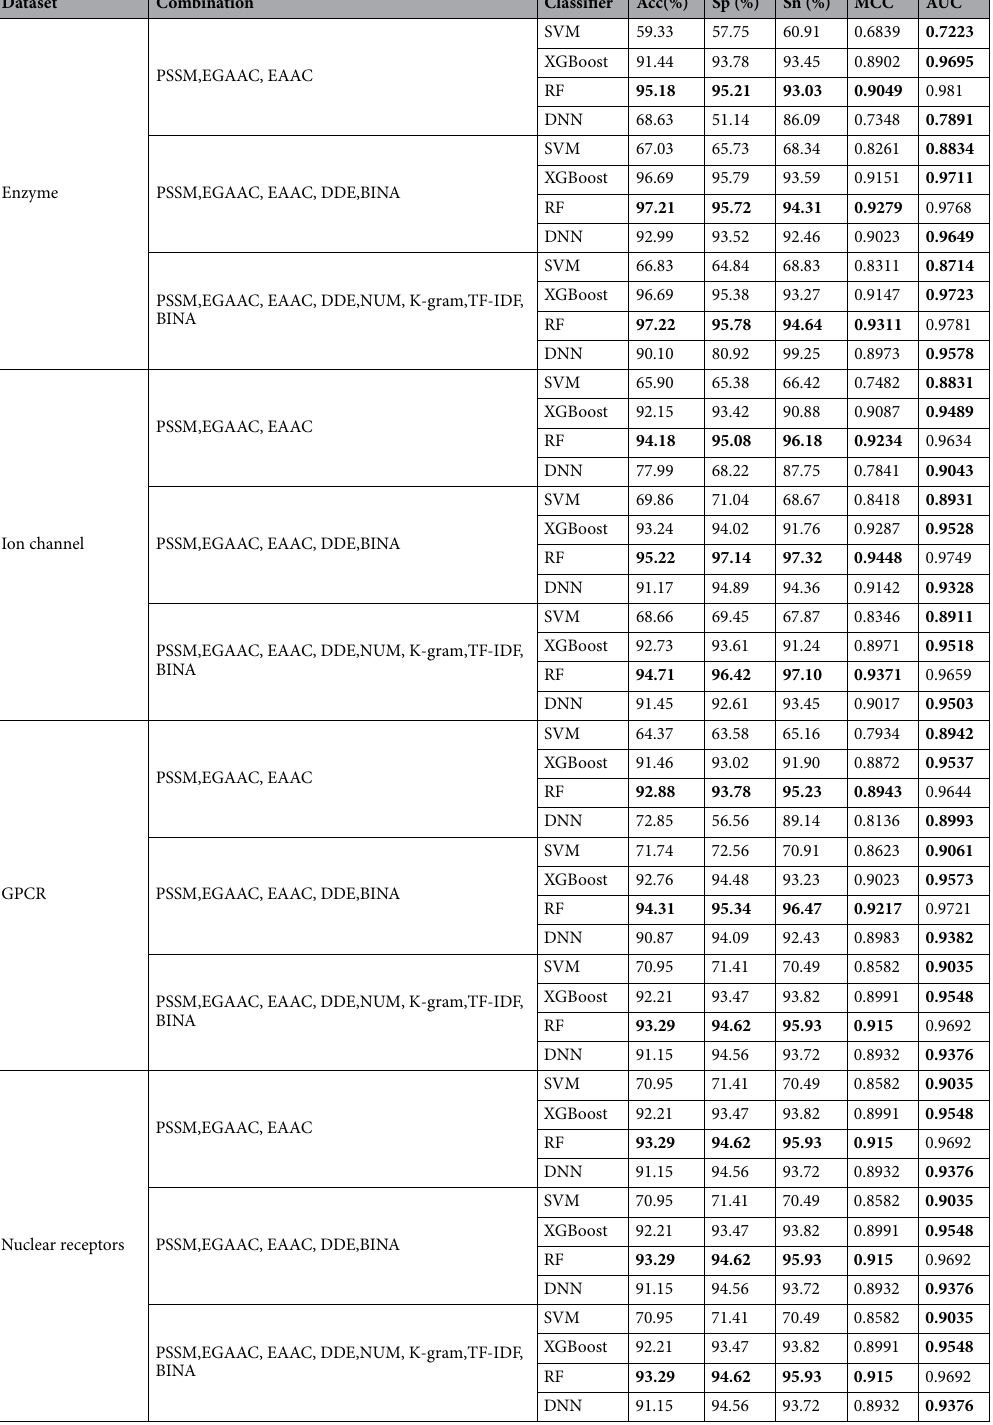
Table 4. Comparison of efficiency criteria of various classifications of different features, without feature selection. Significant values are in